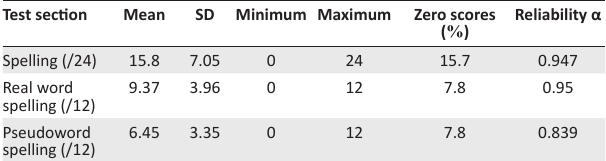
TABLE 1: Descriptive statistics ( N =